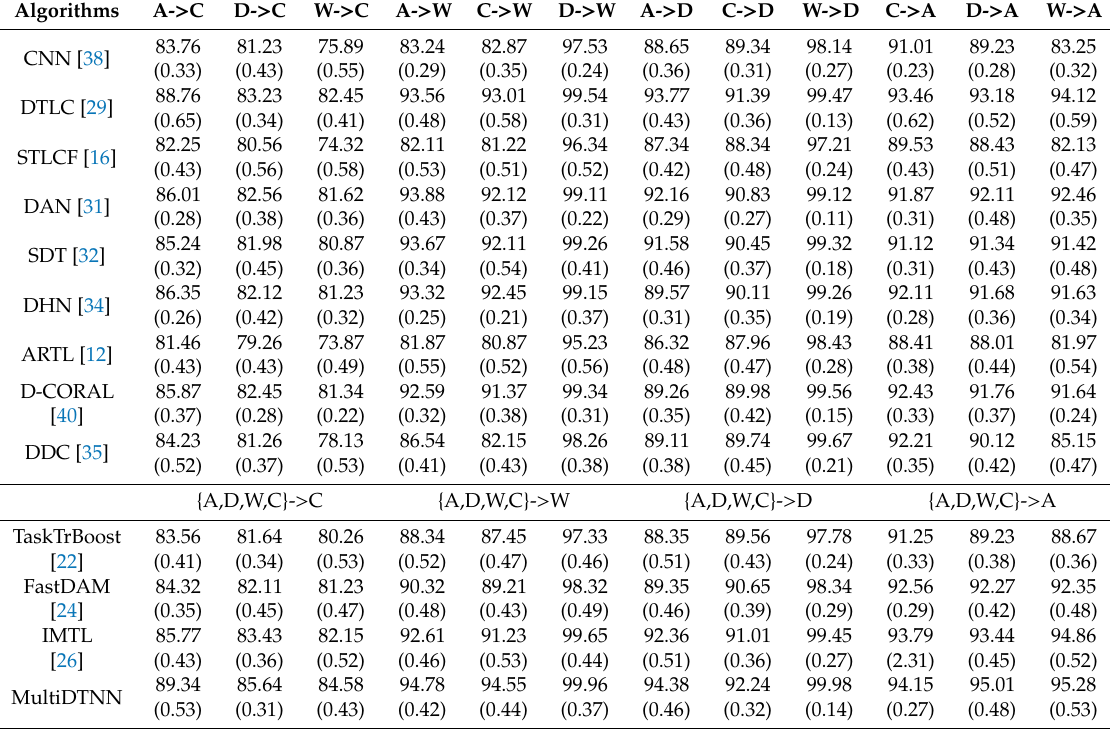
Table 3. Average accuracy rate (%) with absolute value of standard variation on O ffi ce-10 + Caltech-10 dataset.